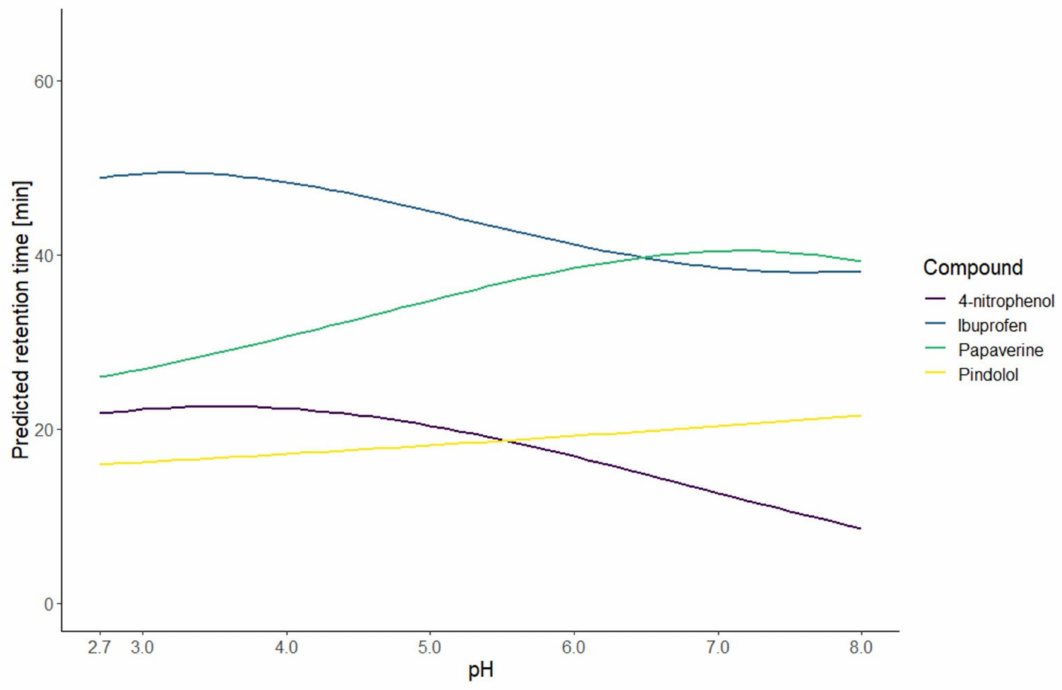
Figure 2. Curves of predicted retention times for the first test set of compounds for all the pH between 2.7 and 8.0 and a gradient time of 60